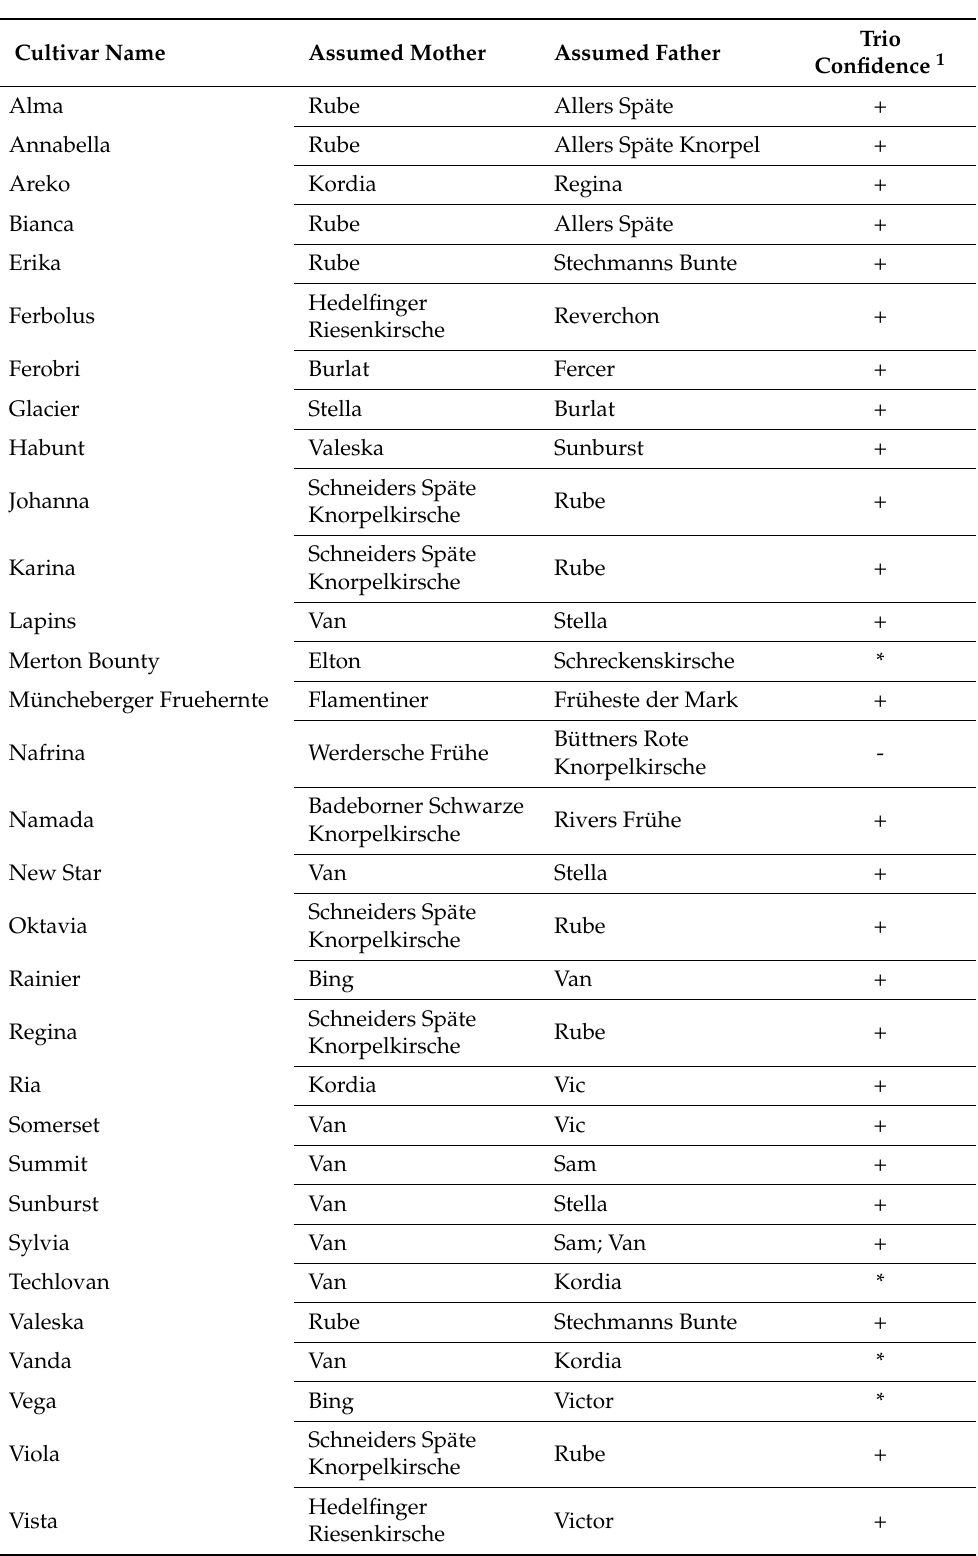
Table 3. Parental analysis for 56 sweet cherry cultivars of the German Fruit Genebank collection, with known parents and an existing SSR genetic data set of at least one